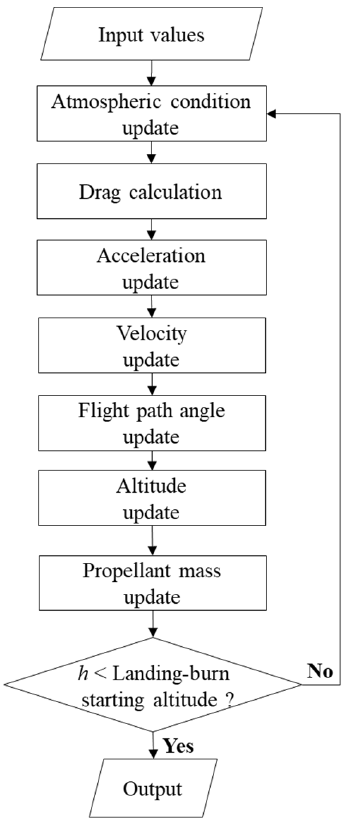
Figure 2. Calculation process of the minimum required propellant weight.